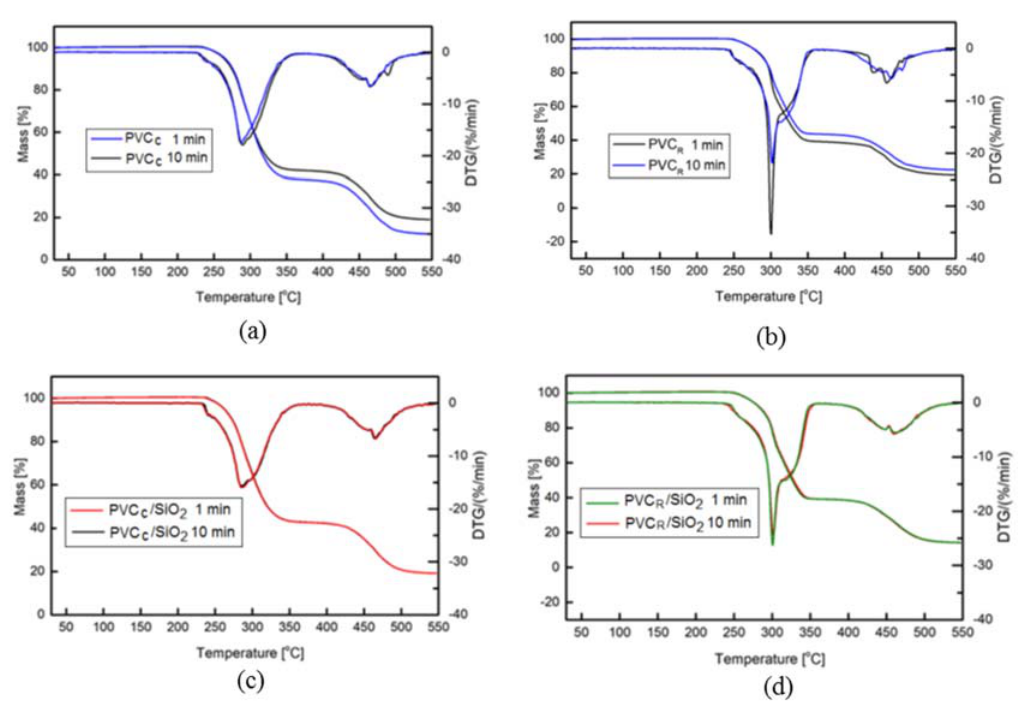
Figure 8. TGA/DTG thermograms of ( a ) PVC C ; ( b ) PVC R ; ( c ) PVC C /SiO 2 , and ( d ) PVC R /SiO 2 processed in 1 and 10 min of rolling